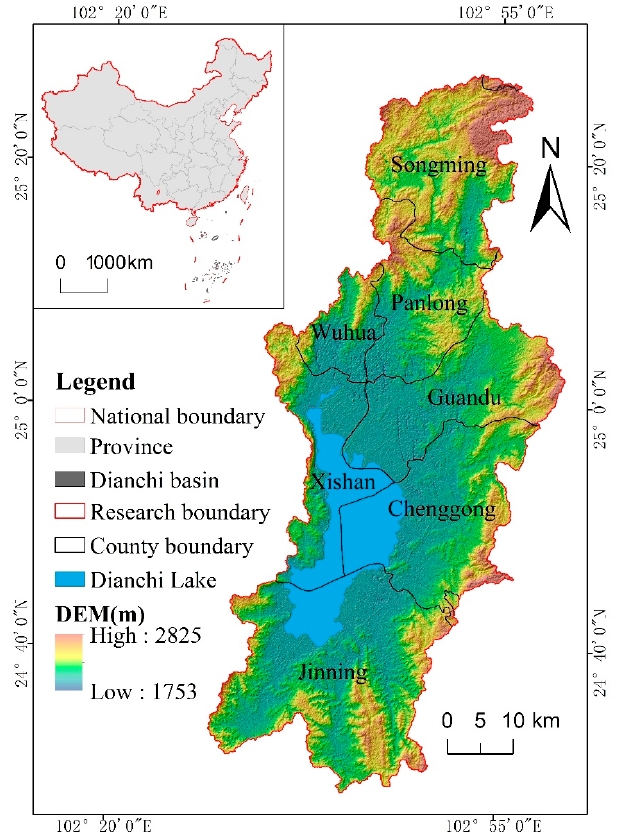
Figure 1. Location of the Dianchin Lake basin, China.